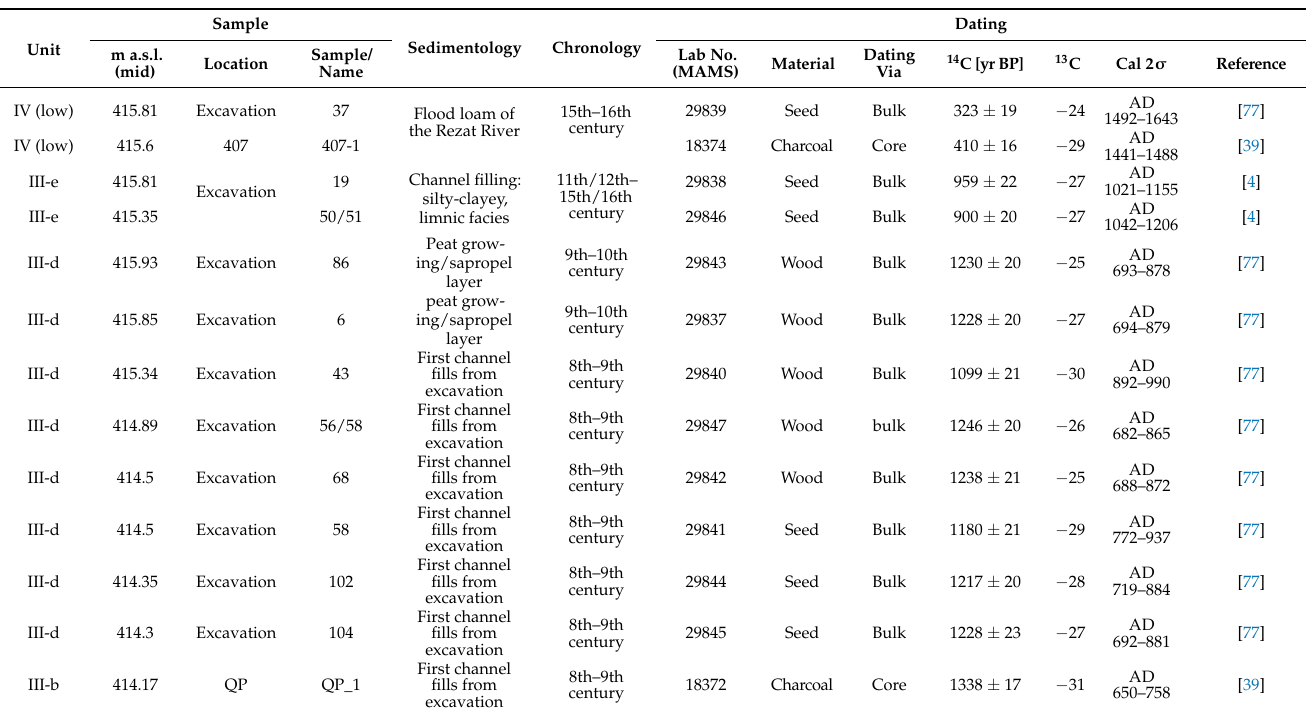
Table 3. Chronostratigraphy of the canal infill in the northern section by radiocarbon dating from the 2013 excavation— Schnitt 1 [4,77] and vibracoring transects 407 and QP